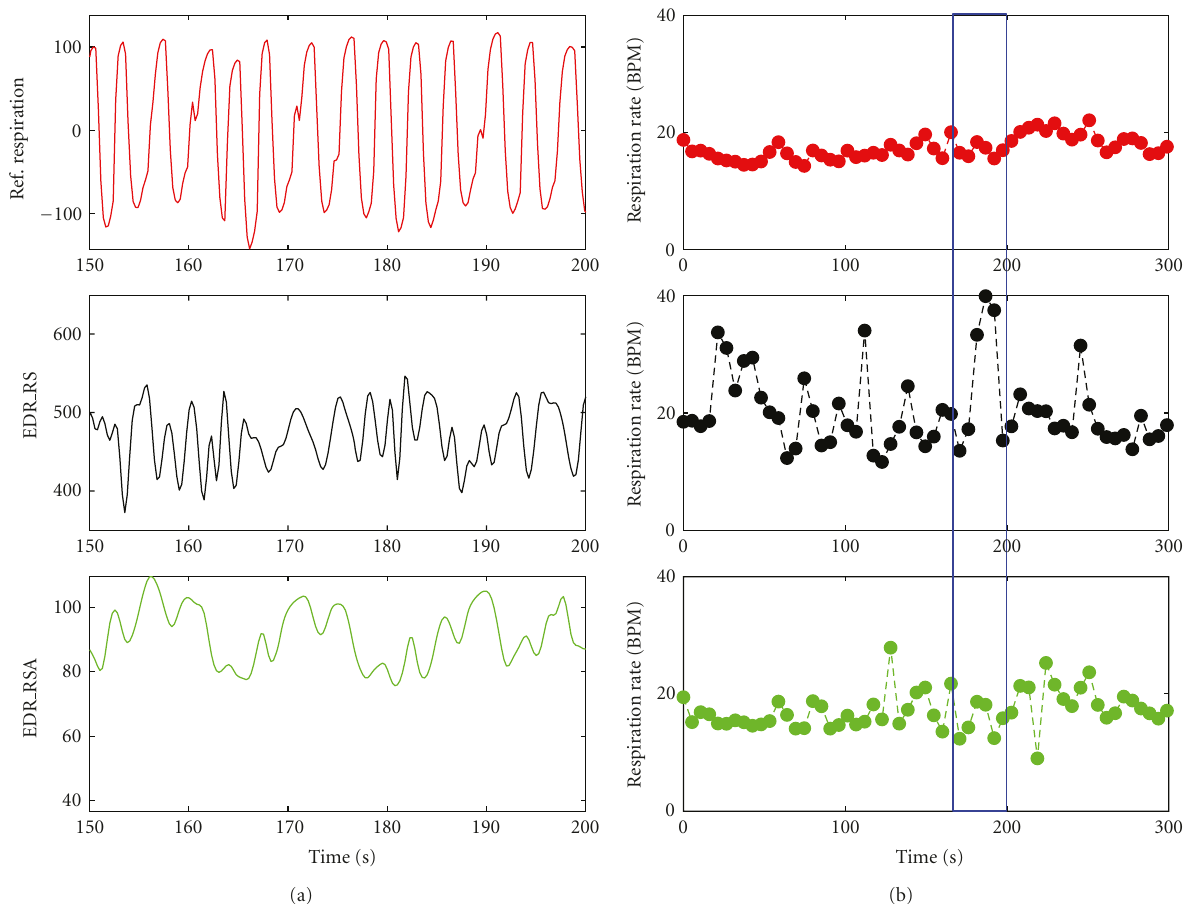
Figure 2: Respiratory rate estimation, from top to bottom: nasal thermistor (taken as the gold-standard), EDR RS (amplitude modulation- based method), and EDR RSA (respiratory sinus arrhythmia-based method). The right panels are the estimated respiratory rates. The left panels are the respiratory waveforms corresponding to the shaded area on the right (note that the original recording was 300 s long. Only the respiratory waveforms corresponding to the shaded area on the right is presented on the left to enhance clarity). Each estimate (closed-circle marks on the right) corresponds to a 20s long window with 15s overlaps between consecutive windows (thus estimates are updated every 5s). For this example, within the shaded area the RSA method provided a better respiratory estimate than the RS